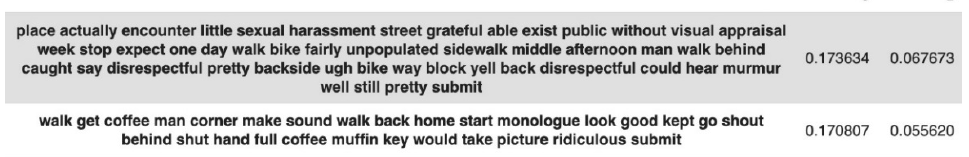
Figure 16. Word2vect results for similar words to “beautiful”.